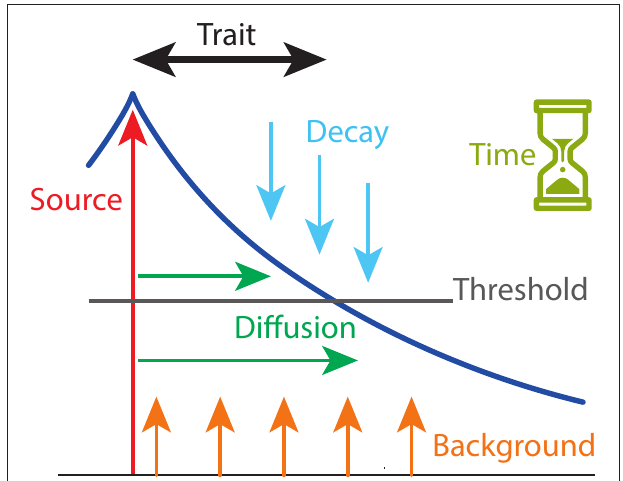
FIGURE 2 | The developmental model of a simple trait, controlled by six parameters. A point source releases a morphogen at a specific concentration (Source), and additional morphogen is produced as a background concentration at every location (Background). The morphogen diffuses away from the point source according to a set diffusion rate (Diffusion), and it decays at another set rate (Decay). After a specific time has elapsed (Time), the morphogen concentration gradient (dark blue line) is compared to a set threshold value (Threshold). The trait value is the distance from the point source within which the morphogen concentration exceeds the threshold